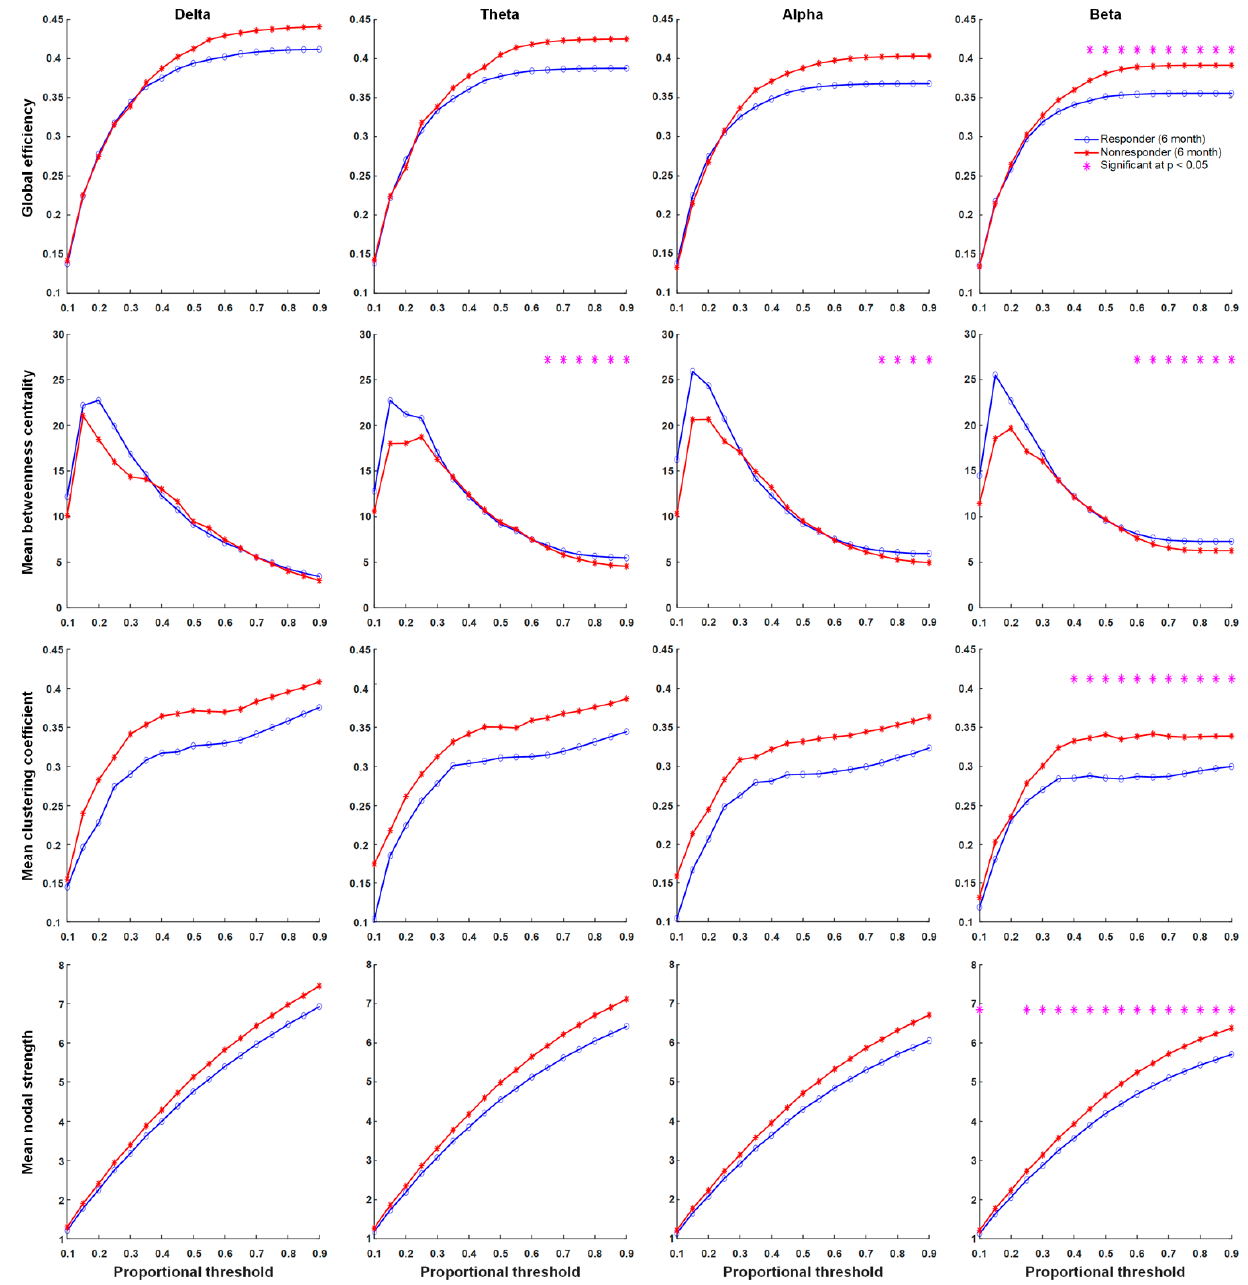
Figure 5. Graph theory-based analyses between responders and non-responders to KDT after six months of KDT show global efficiency, mean clustering coefficient, mean nodal strength, and mean betweenness centrality in delta, theta, alpha, and beta frequency bands. Responders exhibited a significantly decrease in global efficiency, mean clustering coefficient, and mean nodal strength in the beta frequency band for a consecutive range of weighted proportional thresholds. The mean betweenness centrality was increased in the theta, alpha, and beta frequency bands for responders after six months of KDT. Asterisks denote statistically significant differences ( p < 0.05). (KDT: ketogenic diet therapy.)